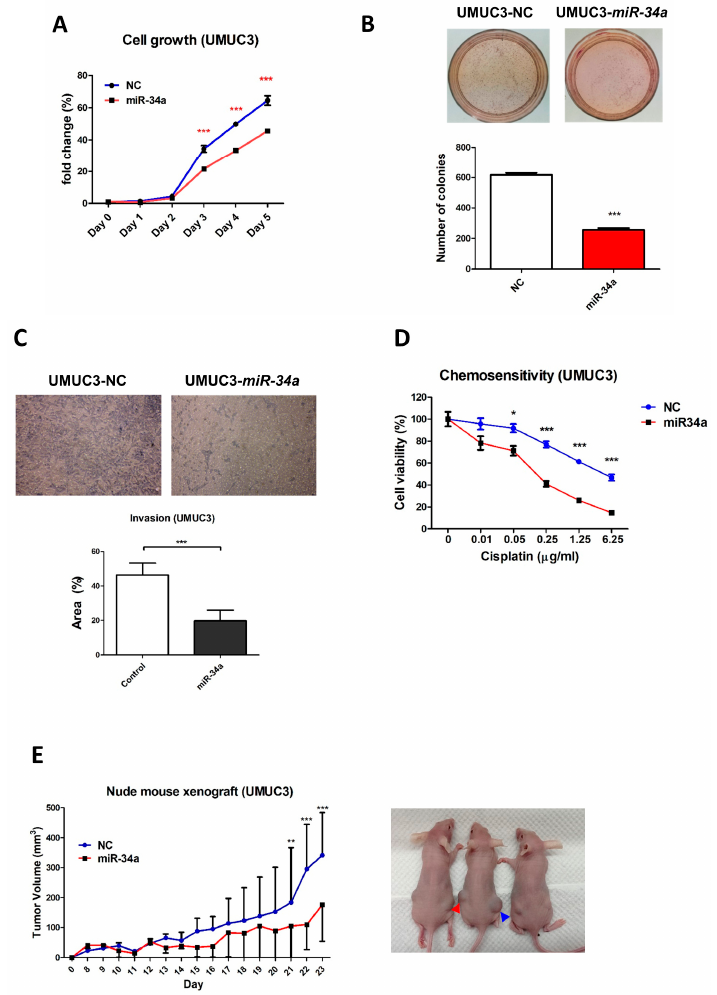
Figure 8. Overexpression of miR-34a suppresses tumorigenicity and drug resistance in UMUC3 UC cells. ( A ) Cell proliferation of UMUC3 cells stably expressing miR-34a or an empty vector was measured using cell counting kits (CCKs), on the designated days. Anchorage-independent growth in UMUC3 cells overexpressing miR-34a was determined using soft-agar ( B ) and cell invasion (magnification 100×) ( C ) assays. Quantitative analysis of the number of colonies in the soft agar and invasion assays indicated below. ( D ) Chemosensitivity to cisplatin in UMUC3 cells overexpressing miR-34a, as determined using a CCK. ( E ) Nude mouse xenograft model showing tumor sizes of UMUC3 cells overexpressing miR-34a (red line) or a control plasmid (blue line). Representative examples of nude mice bearing tumors are also presented (left: miR-34a, red arrow head; right: control, blue arrow head). * p < 0.05; ** p < 0.01, *** p < 0.001.